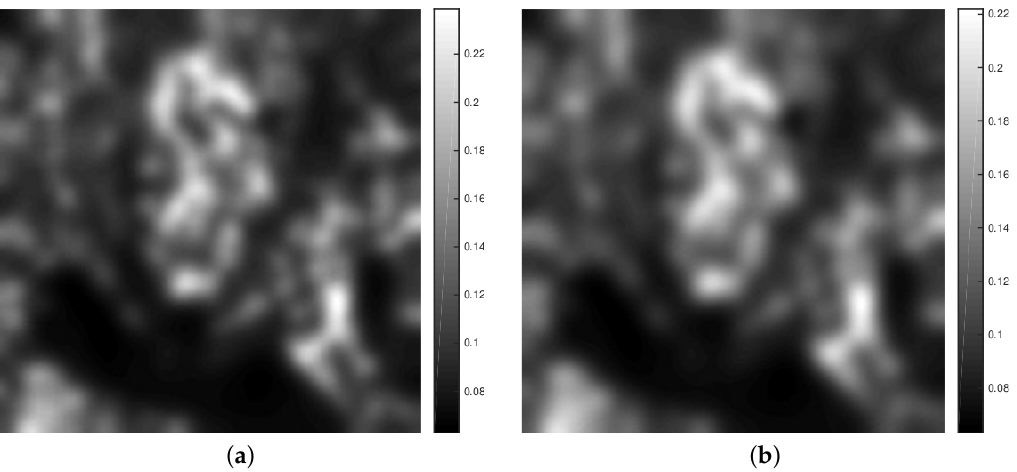
Figure 6. Spatially varying regularization parameter generated by the respective pLATV-algorithm. ( a ) pLATV with pdN with η = 0; ( b ) pLATV with box-constrained pdN.